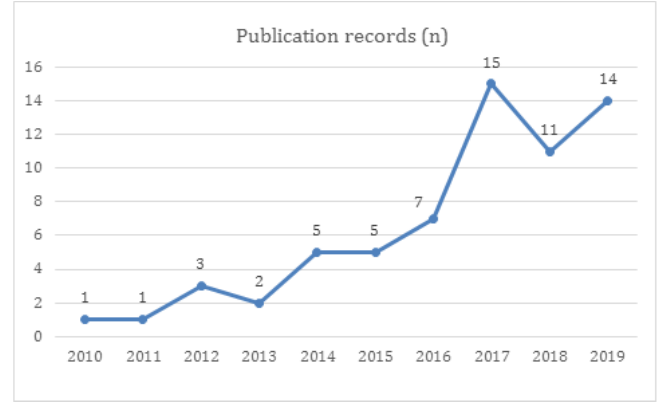
Figure 1. Publication records by